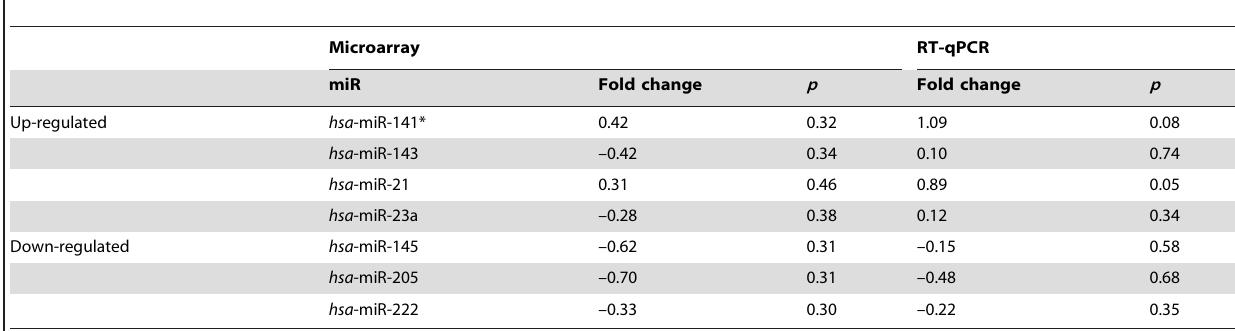
Table 3. The most up- or down-regulated miRNAs in rapid BF group versus non-BF